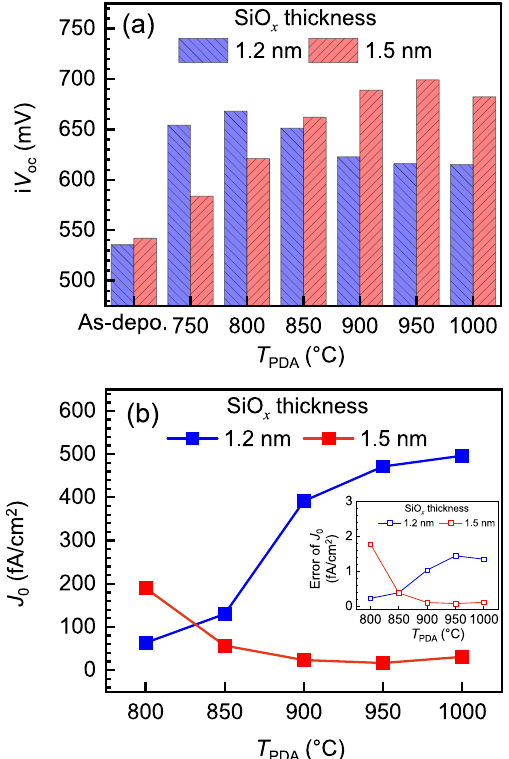
Figure 2. Passivation properties under post-deposition annealing. The measured ( a ) i V OC and ( b ) J 0 values after thermal annealing for the samples with 1.2-nm-thick and 1.5-nm-thick SiO x layers. The inset of ( b ) indicates errors of J 0 values representing the standard errors of the fittings.